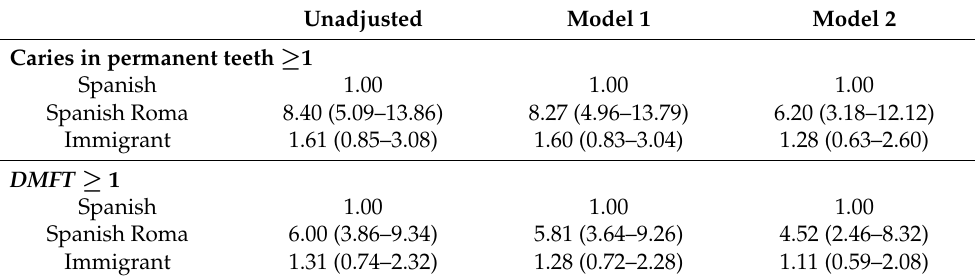
Table 3. Prevalence Ratios and their 95% Confidence Intervals of dental caries outcomes in permanent teeth in children aged 7 to 9 years for parental migratory status/ethnicity: Children’s Oral Health Survey, Municipality of Bilbao, 2017.